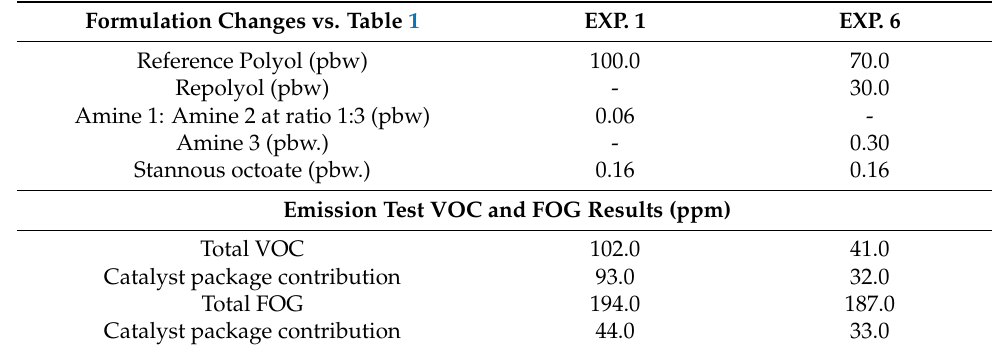
Table 6. Foam emission results of foams obtained with reference polyol (EXP. 1) and using a mixture of reference polyol:Repolyol 70:30 (EXP. 6).